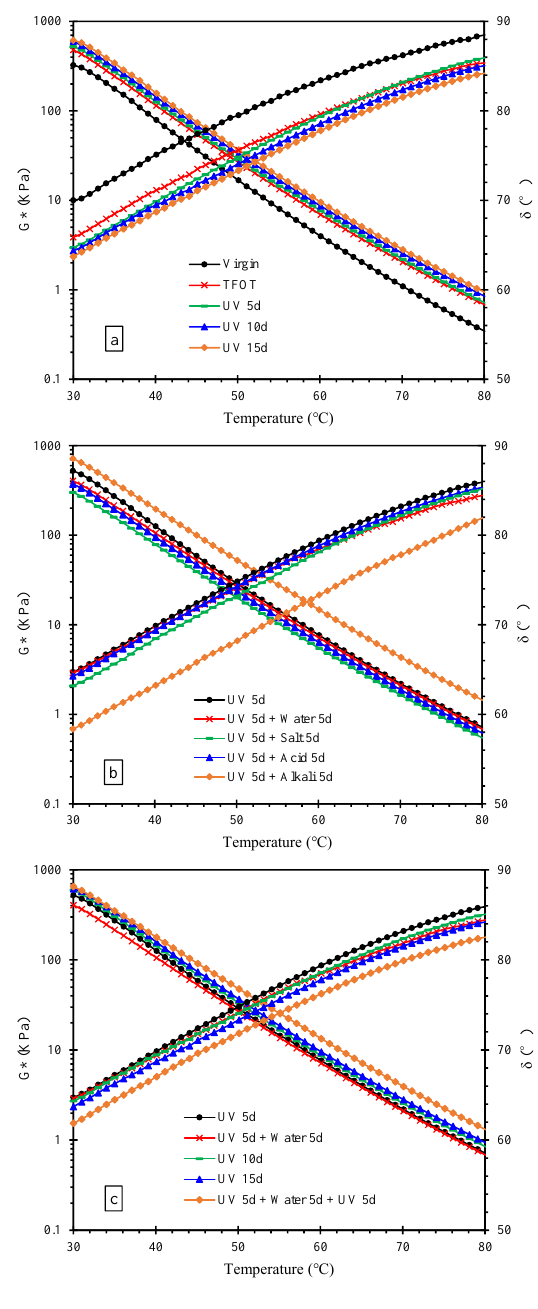
Figure 3. G* and δ of asphalt after the multiple aging of heat, UV and solution. ( a ) multiple aging of heat and UV; ( b ) multiple aging of heat, UV and solution; ( c ) aging cycle of UV and